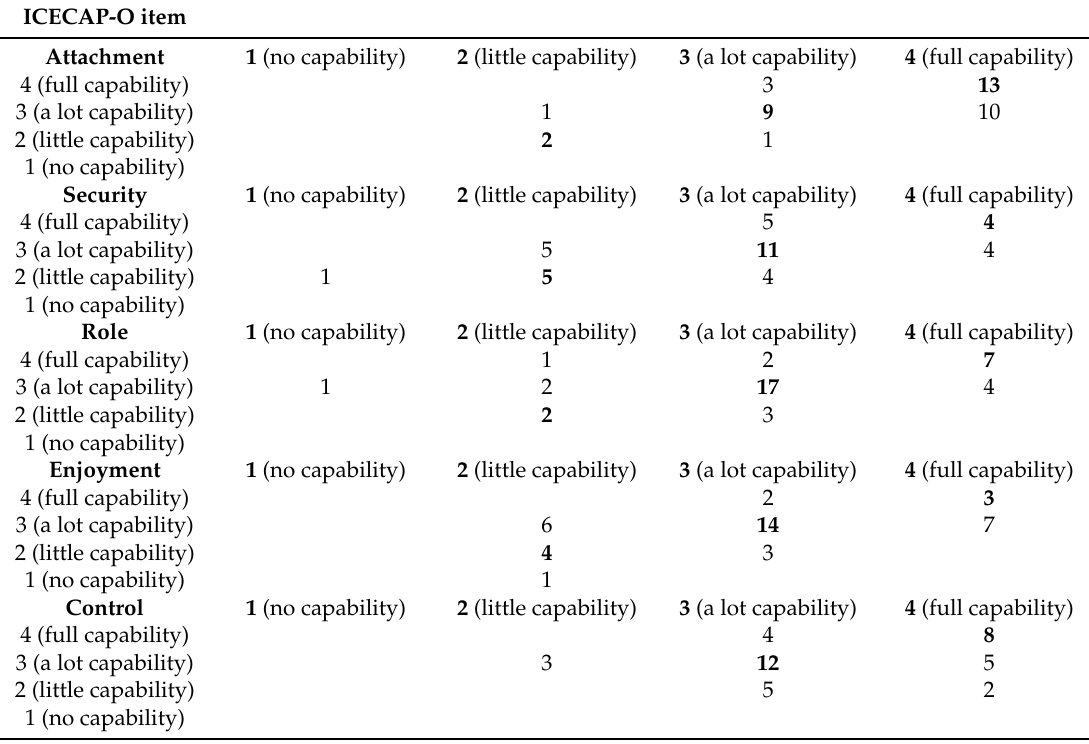
Table 2. Distributions of change in positions between test occasion one and test occasion two for ICECAP-O items (1 = no capability to 4 = full capability), n = 39. ICECAP-O item